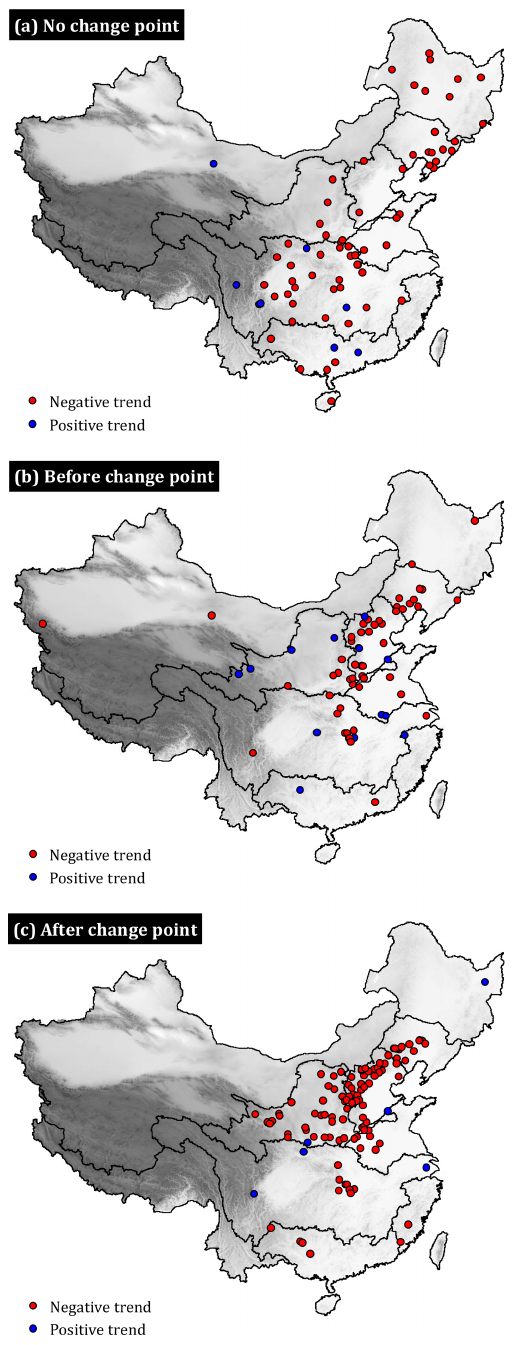
Figure 5. Mann–Kendall test results for stations (a) without a change point in mean and (b, c) with a change point in mean. Re- sults are statistically significant at the level of 5%. A different num- ber of data points between (b) and (c) are associated with (1) insuf- ficient record lengths (e.g., less than 10 years) for sub-groups before or after change points and (2) linear trends for either sub-group not being statistically significant.